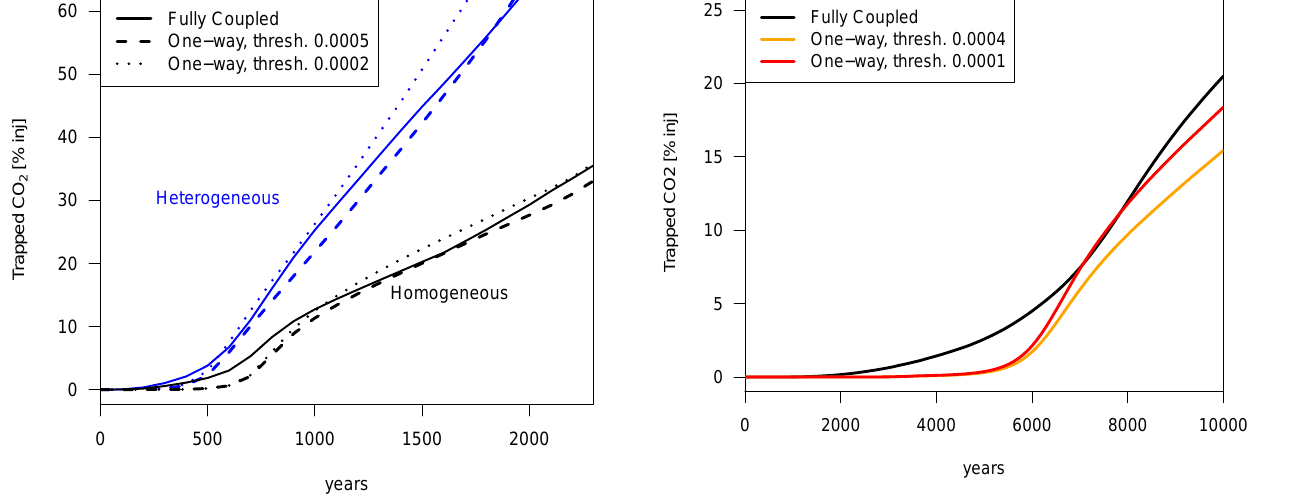
Figure 11. Total carbonate mineralisation in reservoir: comparison between full and simplified coupling. Influence of the choice of threshold value for dissolved CO 2 considered active for the cou- pling in the homogeneous and heterogeneous cases.